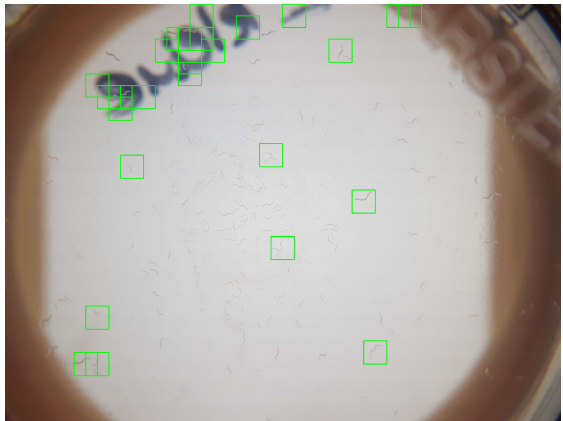
Figure 9. Classification results of complete classified images with unrealistic extreme C. elegans distribution density and age variations.